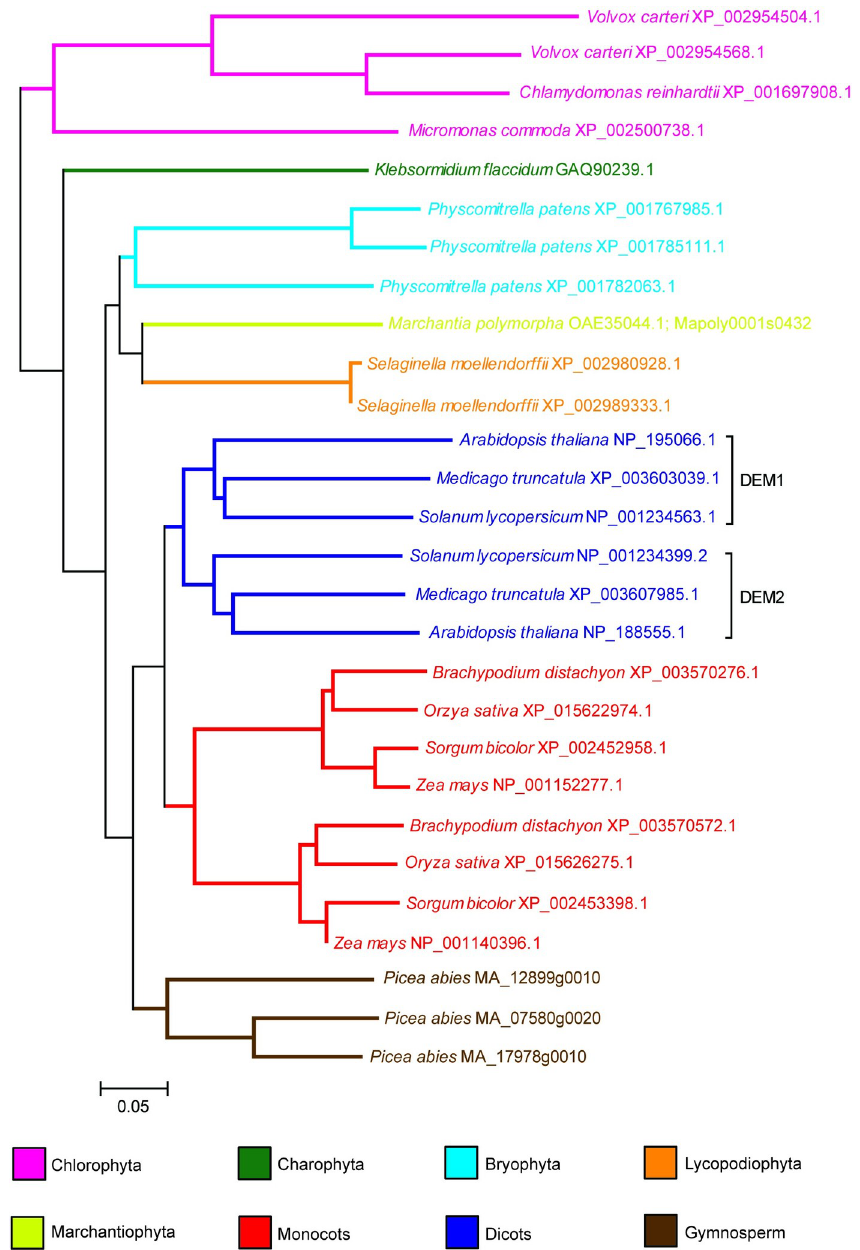
Fig 1. Phylogenetic tree of plant DEM proteins, rooted with the Chlorophyta sequences. Software and parameters used in the analysis are described in Materials and Methods. The name of the organism is indicated on the tree, followed by the accession number or the Conifer Genome Integrative Explorer gene ID for Picea abies . Scale bar indicates 0.05 substitutions per site.